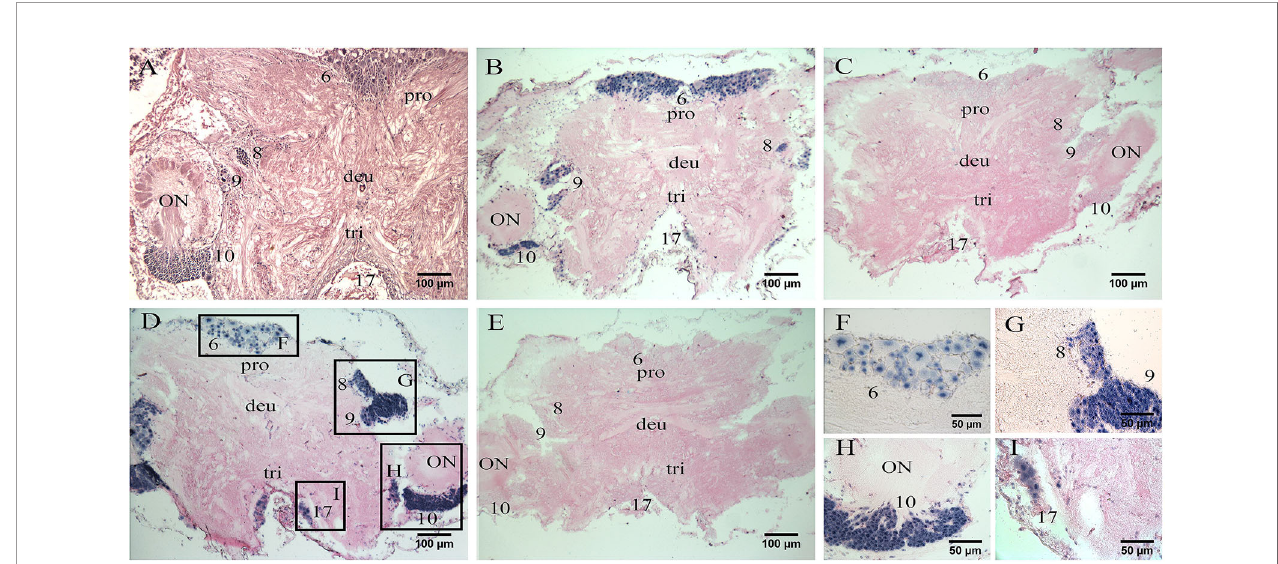
FIGURE 3 | In situ hybridization (ISH) localization of Es-RPCH and Es- b -PDH mRNAs in the brain of E. sinensis . (A) Hematoxylin-eosin staining of a horizontal section of the brain showing the locations of neuronal clusters (numbers) and neuropils. (B) ISH using Es-RPCH antisense probes showing positive signals (blue) in various neuronal clusters of the brain. (C) Negative control of ISH using Es-RPCH sense probes. (D) ISH using Es- b -PDH antisense probes showing positive signals (blue) in various neuronal clusters of the brain. (E) Negative control of ISH using Es- b -PDH sense probes. Scale bars = 100 µm. (F, I) High magni fi cation micrographs showing positive ISH signals in the cluster 6 (F) , clusters 8 and 9 (G) , cluster 10 (H) , and cluster 17 (I) . Scale bars= 50 µm. ON, olfactory neuropil; pro, protocerebrum; deu, deutocerebrum; tri, tritocerebrum.